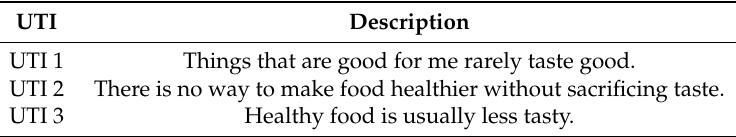
Table 2. Items used in the unhealthy = tasty intuition (UTI) scale.